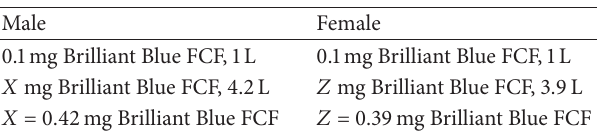
Table 2: Calculus